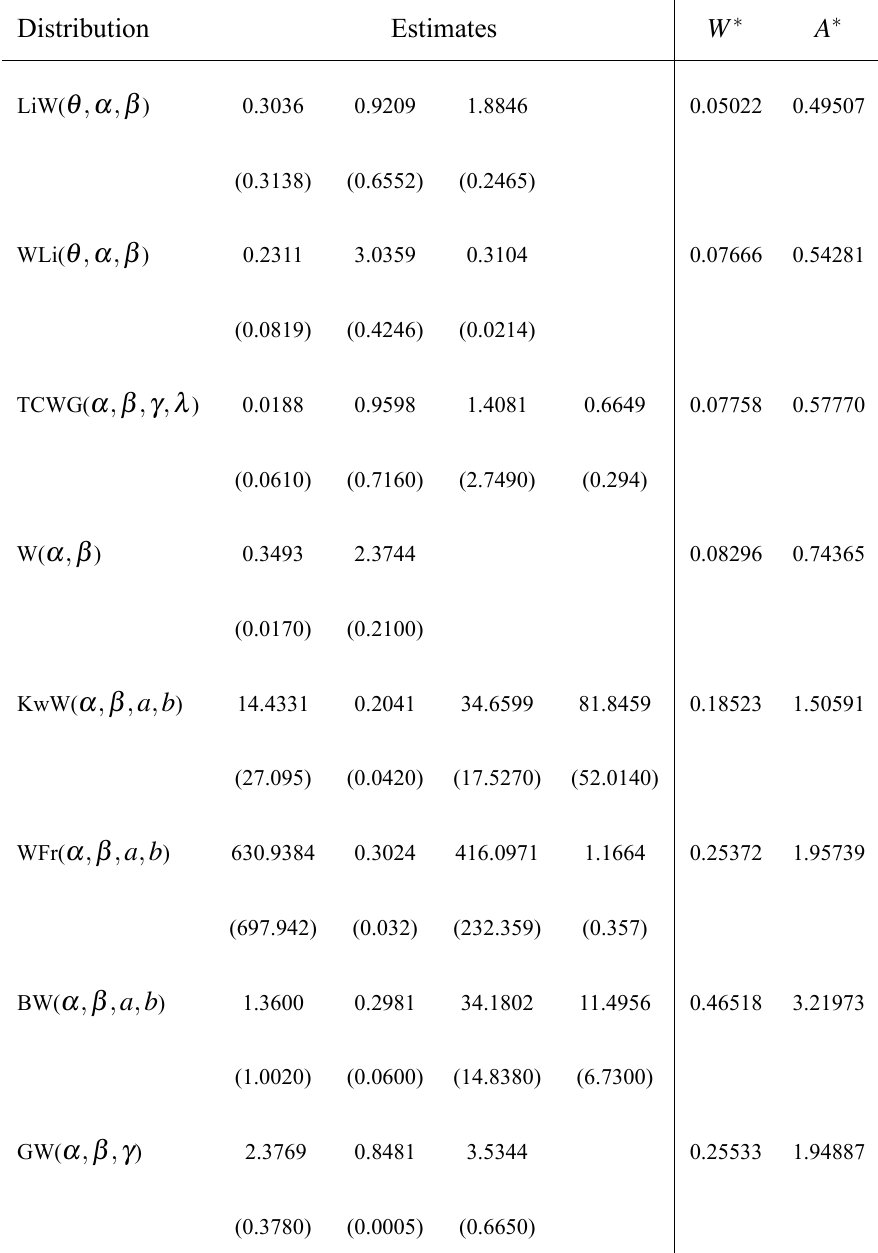
MLEs (standard errors in parentheses) and the statistics W ∗ and A ∗ for data set